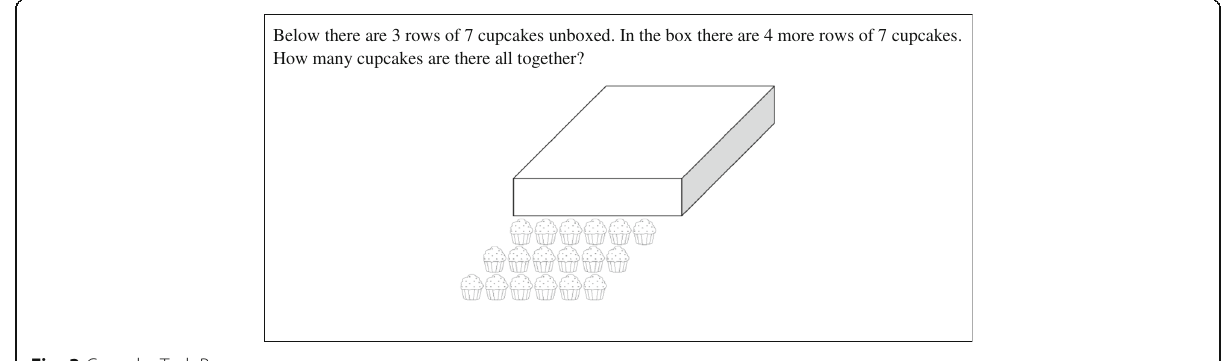
Fig. 3 Cupcake Task B